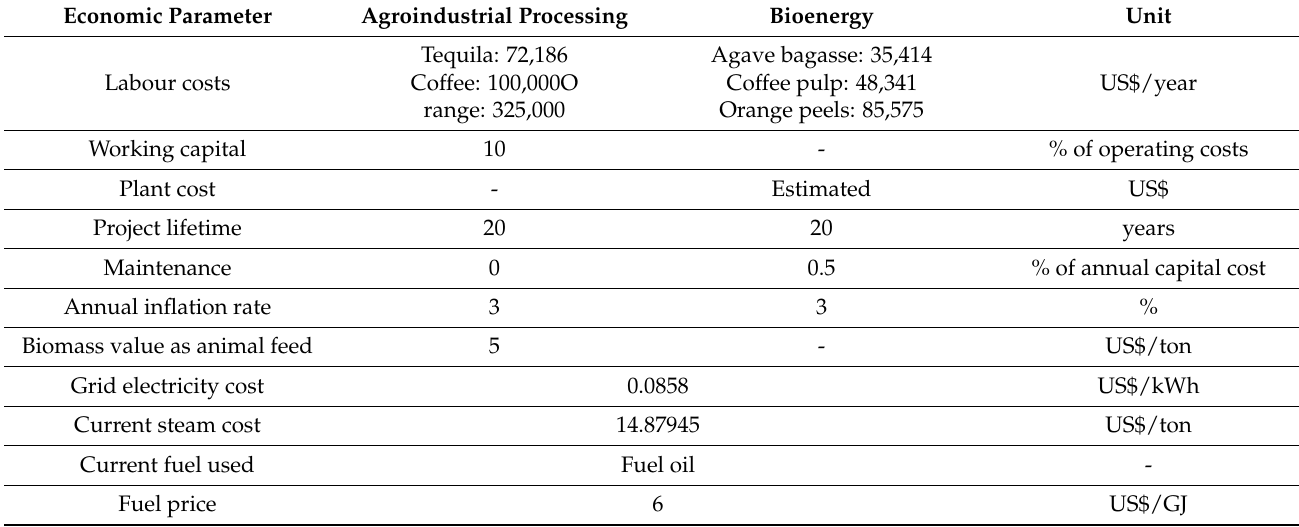
Table 4. General economic evaluation